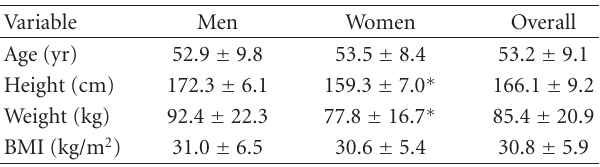
Table 1: Subject characteristics at the baseline (Men = 23, Women = 21, Overall =